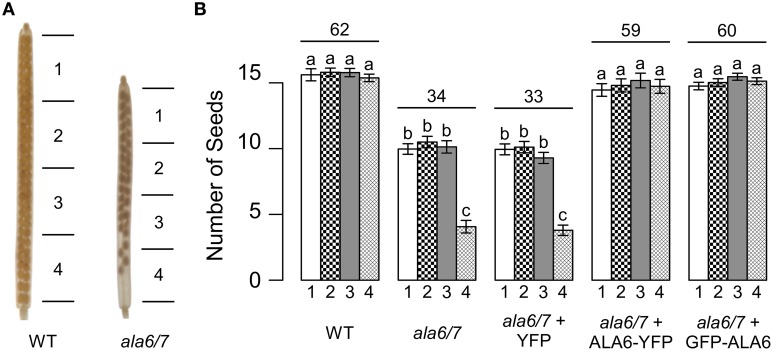
Loss of ALA6 and ALA7 results in reduced seed set with an uneven distribution of seed. (A) Representative examples of wild-type and ala6-1/7-2 siliques cleared with 70% EtOH to show seed positions. (B) Graph of seed set by sector. Siliques were divided into four sectors of equal length with sector 1 at the top (stigma end) of the silique and sector 4 at the base of the silique. Average results (±SE) are reported for two independent experiments, n = 35–93 siliques. Siliques were collected from a total of 5–13 plants for each genotype. Sector numbers appear below each column and the average total seed set for each genotype is given above the corresponding sector data. For the GFP-ALA6 rescue construct, 7/9 lines showed equivalent rescue of ala6-1/7-2: ss1878–1884. For the ALA6-YFP rescue construct, 4/6 lines showed equivalent rescue of ala6-1/7-2: ss1885–1888. a,b,cColumns sharing common labels (letters) are not significantly different from each other (p > 0.05).